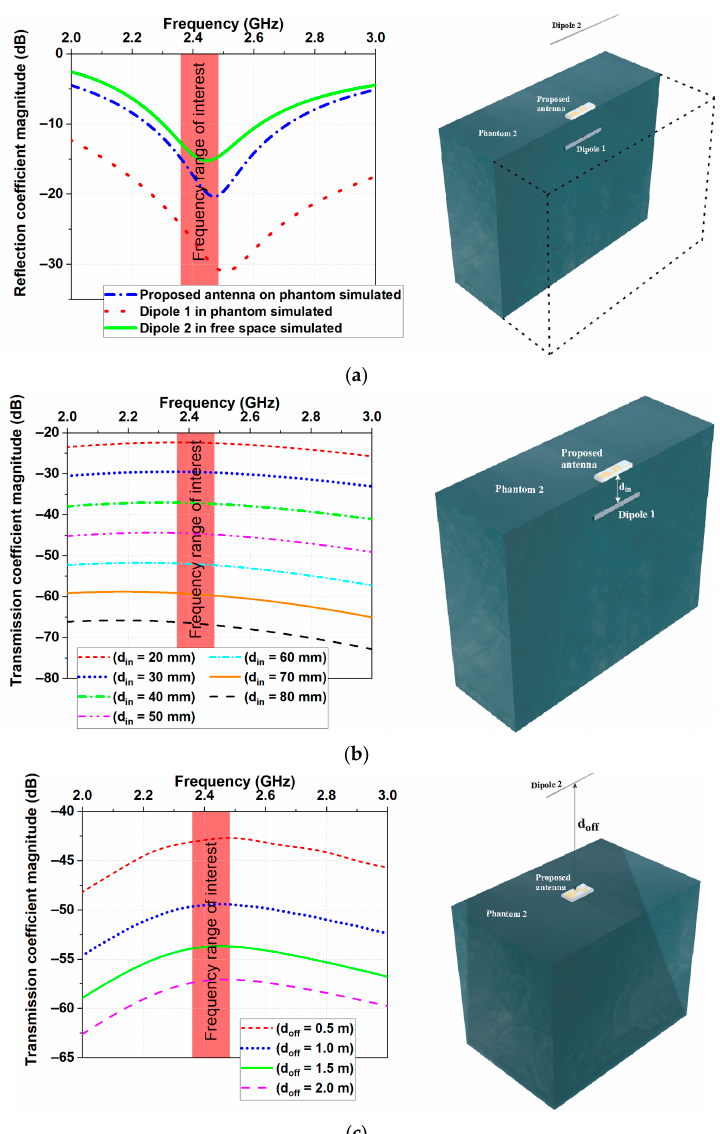
Figure 6. Simulated ( a ) reflection coefficients, ( b ) transmission coefficient for in- to the on-body sce- nario, and ( c ) transmission coefficient for on- to the off-body scenario. Illustrations of the setup for S-parameter simulations and measurements.